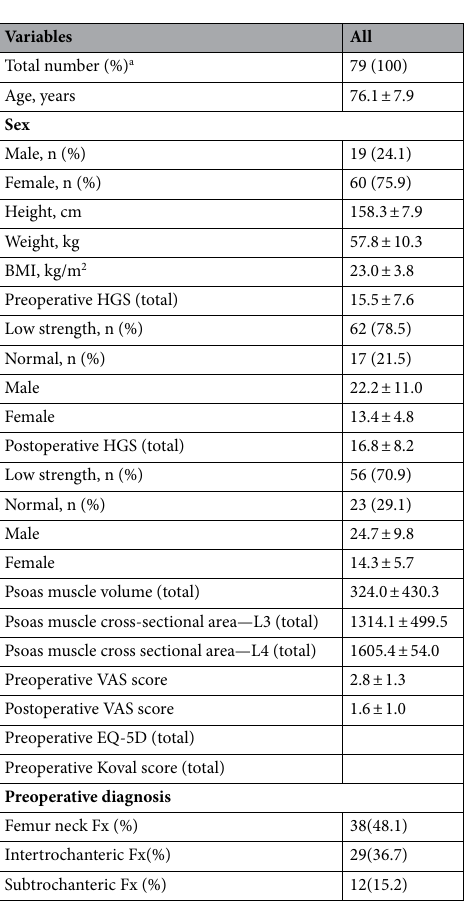
Table 1. Baseline characteristics. BMI body mass index, Fx fracture, VAS visual analog scale, SD standard deviation. a Calculated the result rounded up to the first digit after the decimal point.